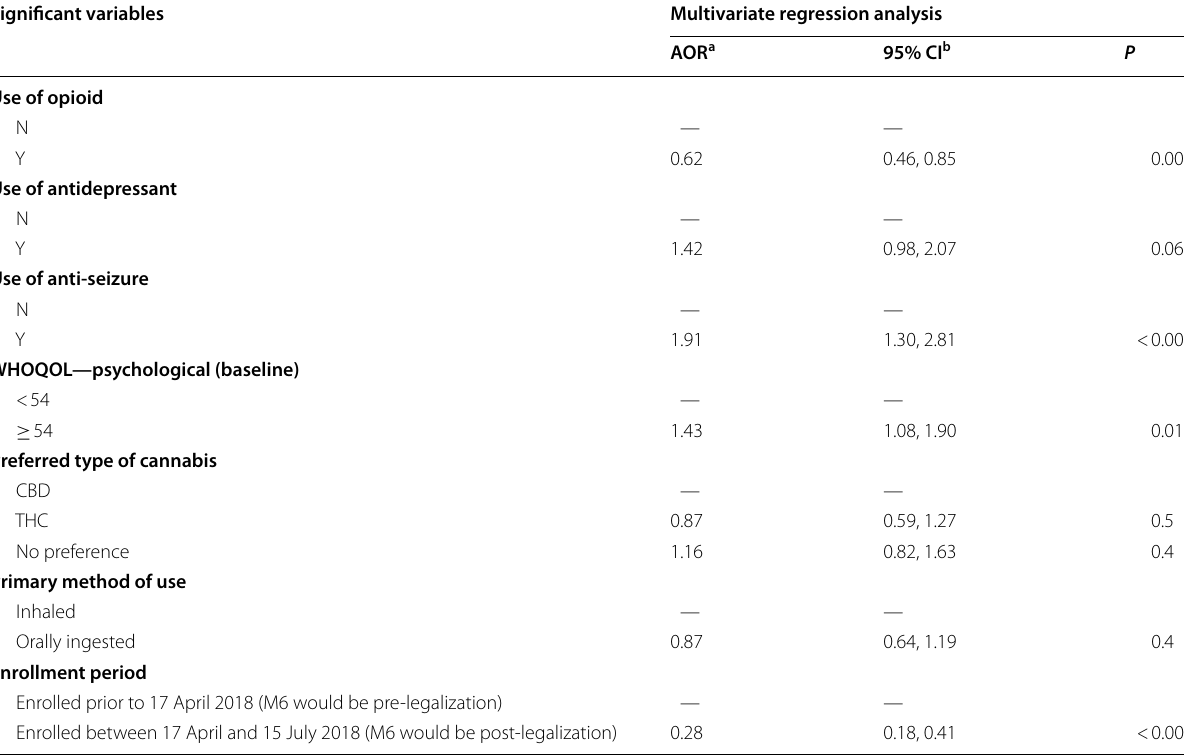
a AOR Adjusted odds ratio, b CI Confidence interval